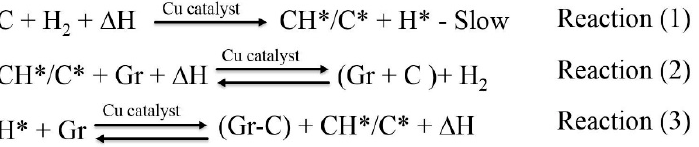
Figure 4. Scheme 1: Graphene growth mechanism’s governing reactions; here C represents the carbon atom, Gr represents graphene, CH*/C* represent hydrogen bonded-carbon radical/carbon radical, H* represents the hydrogen radical and ∆ H represents heat (permission to modify the scheme has been obtained).